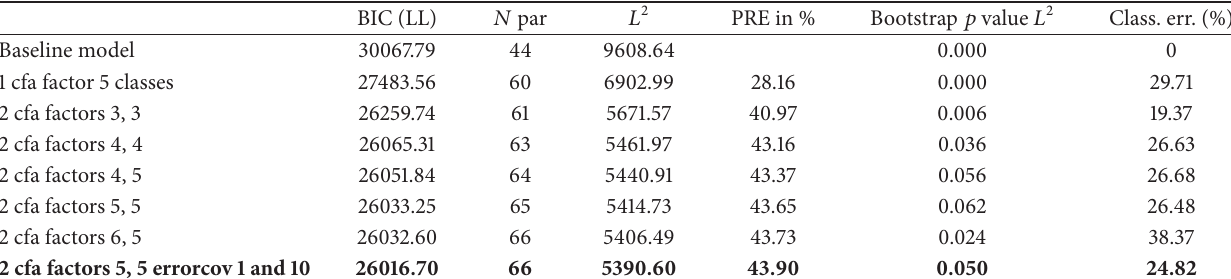
Table 1: Models and their fit